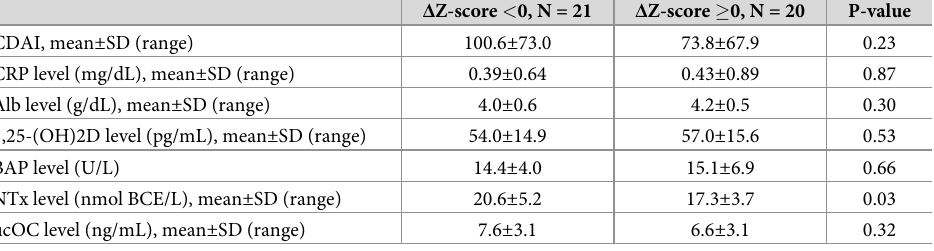
significantly negative correlation was observed between the mean serum NTx value and the fem- oral Δ Z-score (r = 0.4180, P = 0.0068) (Fig 2b). A significantly positive correlation was noted between the mean serum albumin value and the femoral Δ Z-score (Fig 2c). Although the mean NTx value was not correlated with the CDAI (P = 0.3549), there was a significant correlation between the mean serum albumin value and CDAI (P = 0.0042, r = 0.4377). Relationship between anti-TNF- α therapy and serum NTx value We evaluated the relationship between anti-TNF- α therapy and the NTx value. In the anti- TNF- α administration group, the NTx value did not differ significantly between the first and Table 3. Comparison of the biomarker values at the initial measurement between the groups of patients with Δ Z- score < 0 and Δ Z-score > 0.